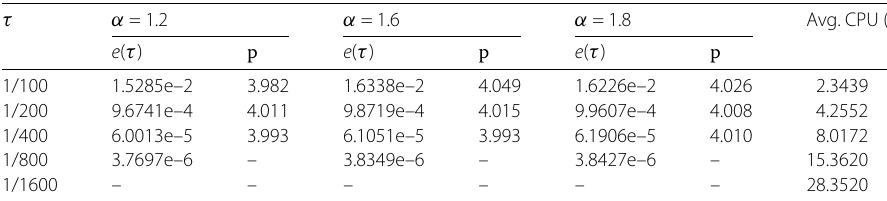
Table 1 Convergence rates of the ETDRK4-P22 scheme in time τ α = 1.2